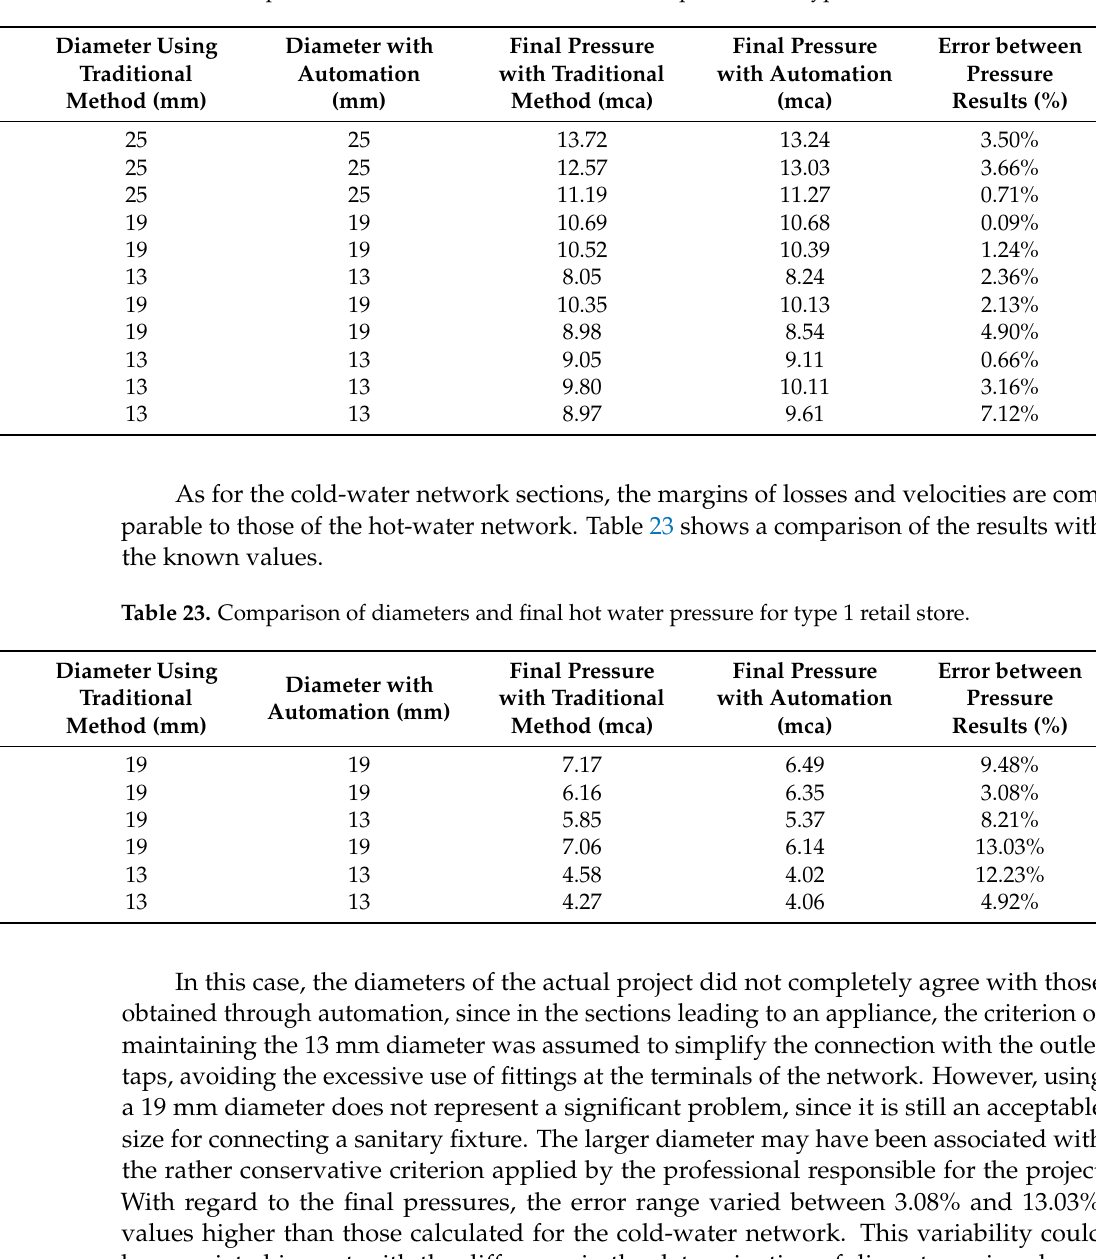
Table 22. Comparison of diameters and final cold water pressure for type 1 retail store.